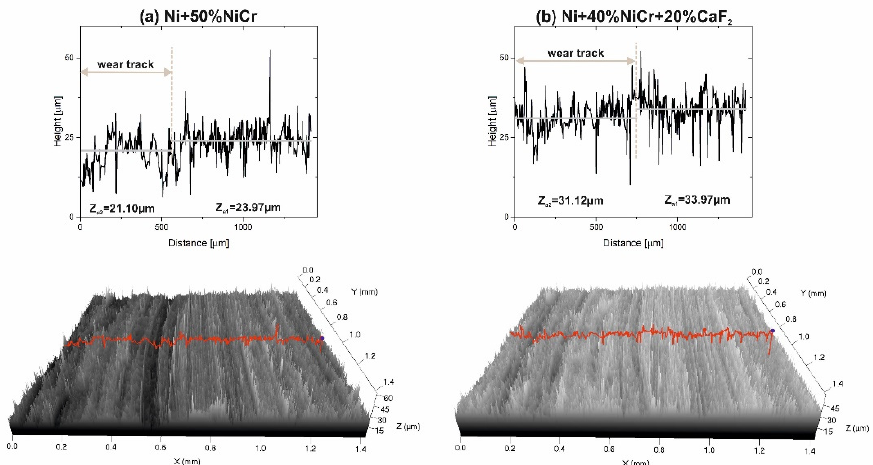
Figure 12. Stereometrics profiles of the counter-samples combined with Ni-50%NiCr(80/20) ( a ) and Ni-40%NiCr(80/20)-20%CaF 2 ( b ), after wear test at 400 °C.